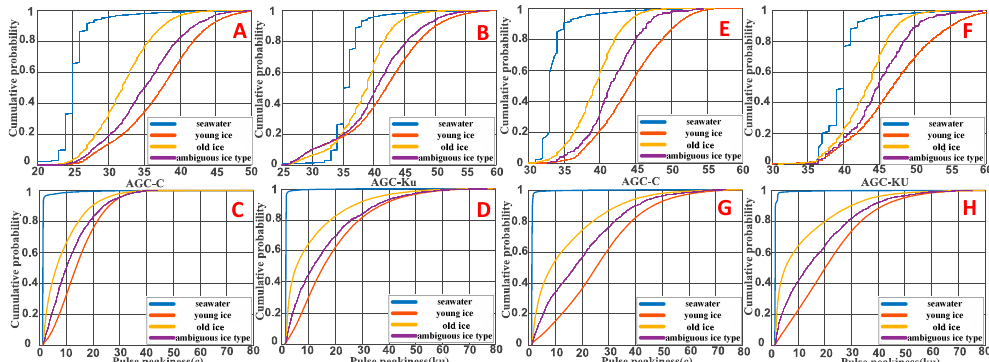
Figure 7. Cumulative probability distributions for the four cases (seawater, young ice, old ice, and ambiguous ice) for the four waveform parameters: AGC of the C Band; AGC of the Ku Band; PP of the C band; PP of the Ku band. Note: A – D are the results of the HY-2A; E – H are the results of the HY-2B.